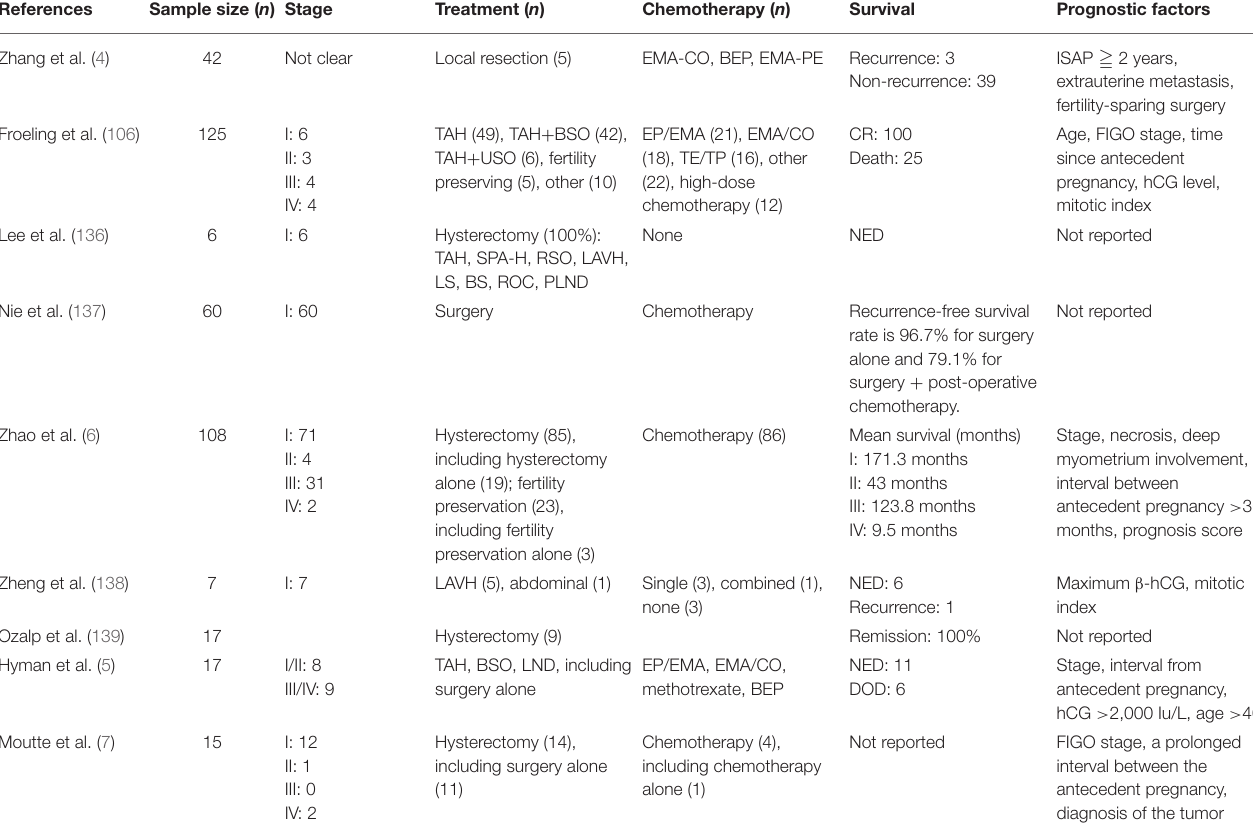
TABLE 6 | Related treatments and survival outcomes of PSTT reported in the recent